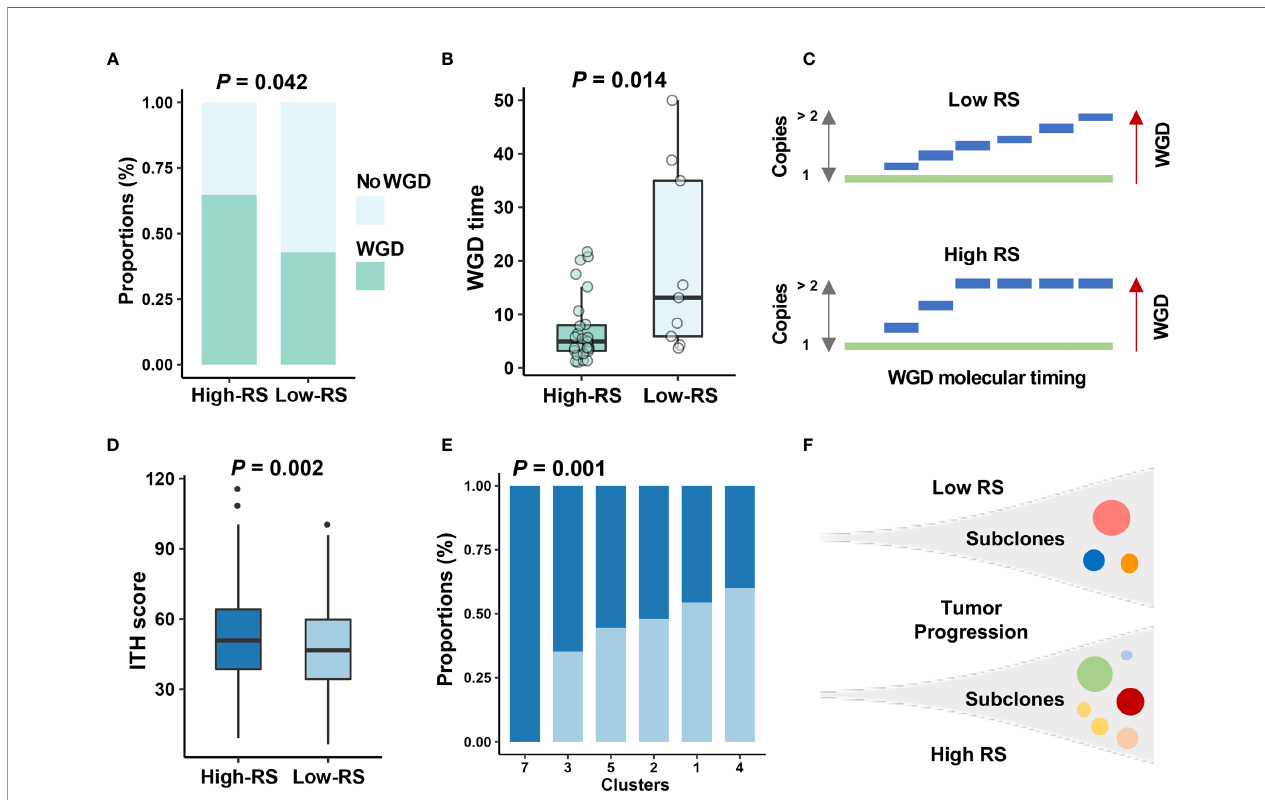
FIGURE 6 | The relationship between fi ve-cytokine signature and tumor evolution history. (A, B) In TCGA data, more WGD events (see Methods ) were found to be enriched in high-RS BC samples, and the shorter WGD timing (see Methods ) was further observed in the high-RS group, which were suggested by Fisher ’ s exact test and Wilcoxon rank sum test, respectively. (C) Schematic diagram indicated that high-RS correlated with more proportions of WGD events and earlier WGD timing before the appearance of the MRCA among all BC cells. (D, E) The higher ITH scores and more mutational clusters were revealed in the high-RS group using MATH algorithm (see Methods ). P values were indicated by Wilcoxon rank sum test and Fisher ’ s exact test separately. (F) Schematic diagram indicated that high-RS tumors harbored more subclones during the tumor progression of